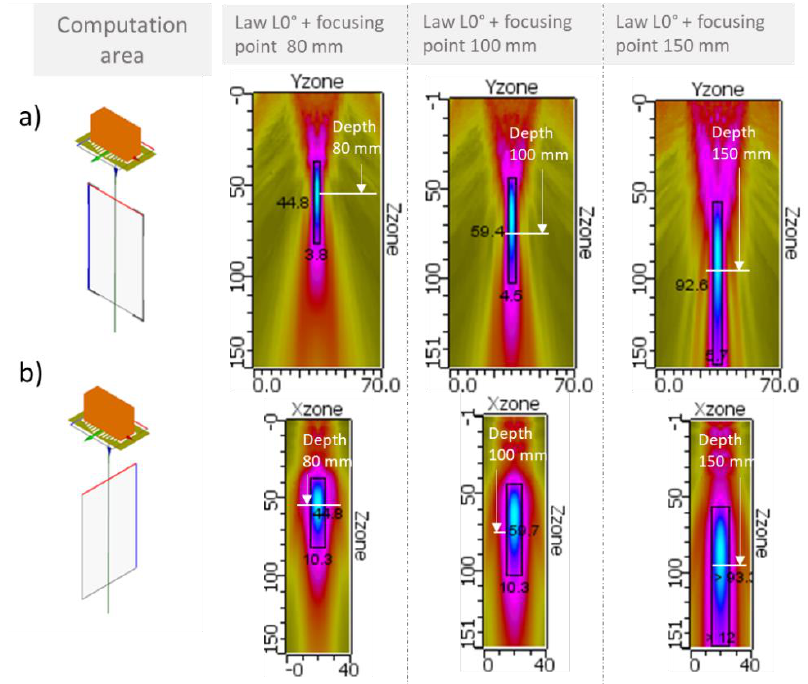
Figure 9. Simulation results. Longitudinal ultrasonic field radiated in liquid sodium by the 12-element EMAT. Delay laws applied to focus at 80 mm, 100 mm and 150 mm without beam deflection (law L0°). Computation of the field in two 2D areas located in the focal plane (figures a)) and in the orthogonal plane (figures b)). Excitation signal at 1 MHz composed of 3 bursts (signal close to the experimental one used in Section 4).